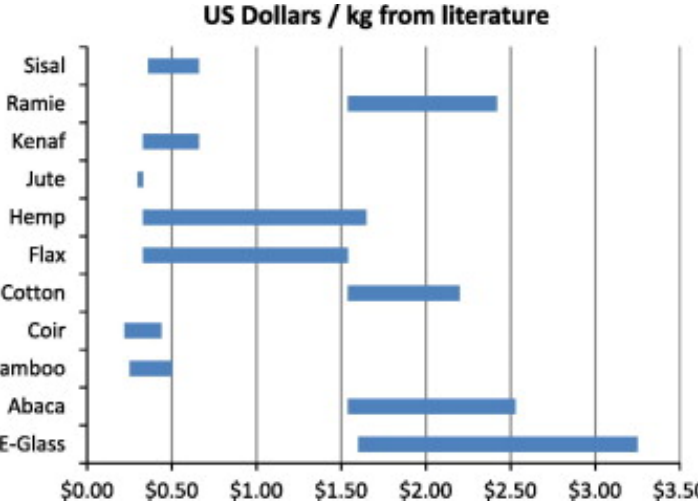
Figure 1. Cost per kg weight comparison between glass and natural fibres. Reprinted with permission from Reference [14]. Copyright 2012, with permission from Elsevier.